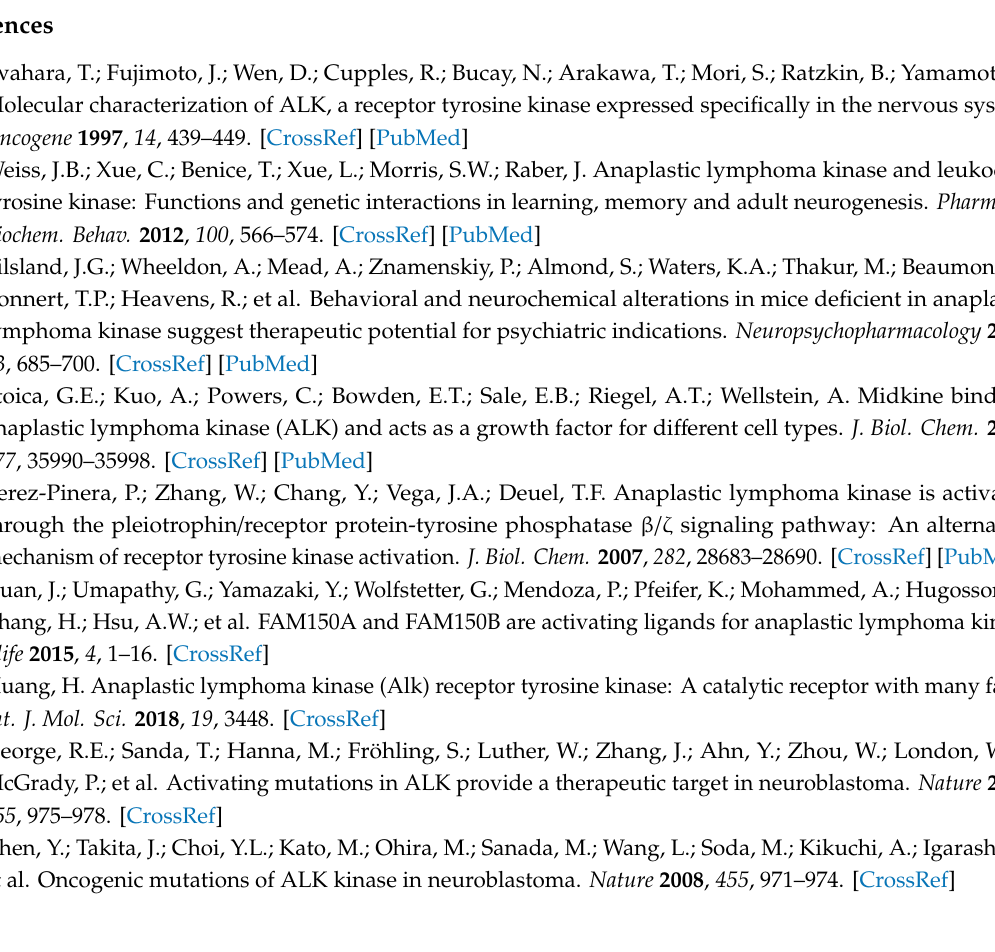
of ALK-HA in Dox-treated cells, Figure S5: Full-length blots of Figure 1, Figure S6: Full-length blots of Figure 3, Figure S7: Full-length blots of Figure 6, Figure S8: Full-length blots of Figure